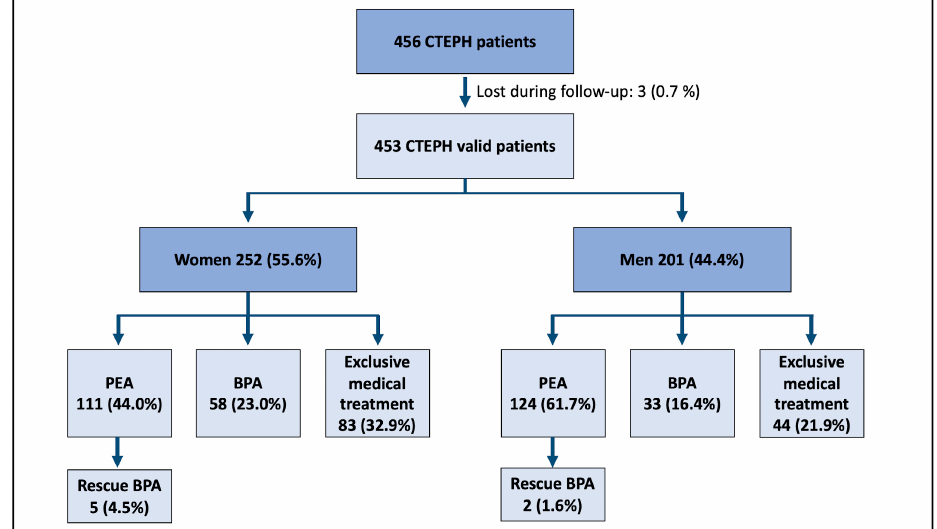
Figure 2. Flow chart of included patients. CTEPH (chronic thromboembolic pulmonary hyperten- sion), PEA (pulmonary endarterectomy), BPA (balloon pulmonary angioplasty).